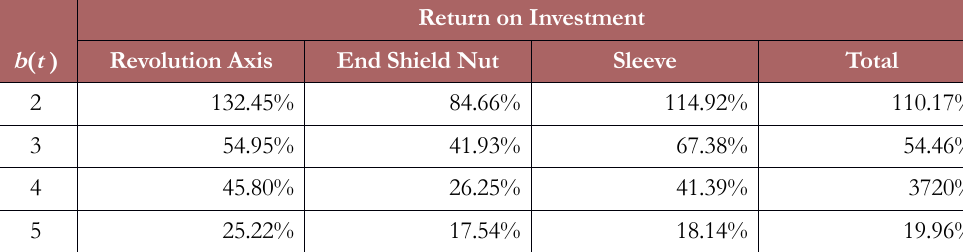
Table 27. Effects of Interruption time to the